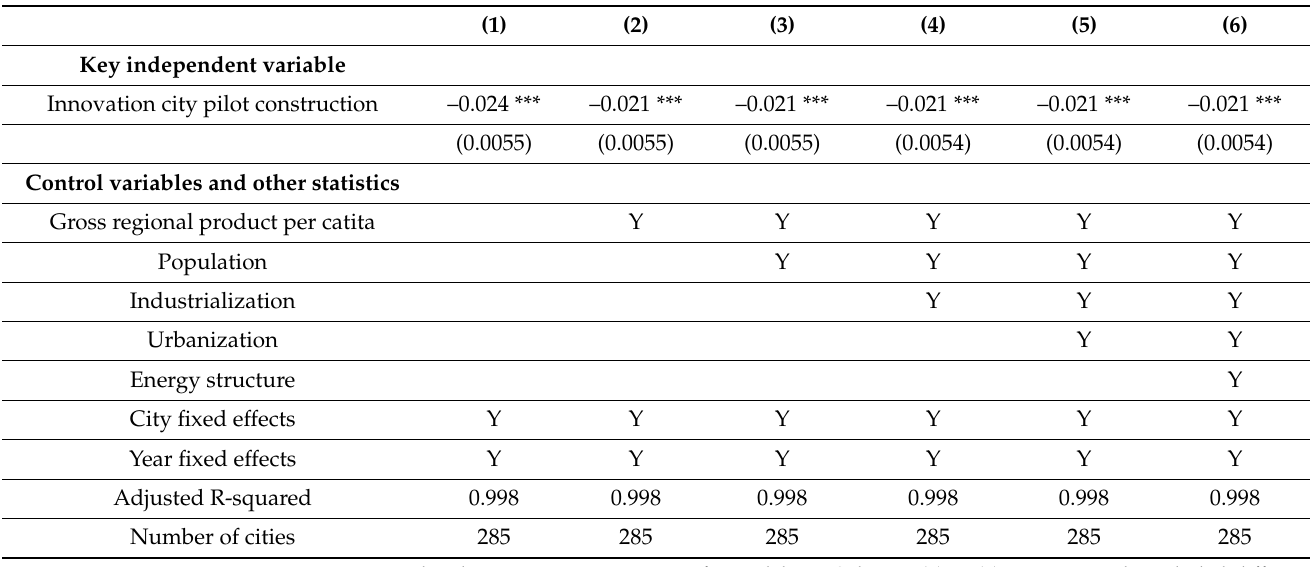
Table 1. Estimates in the impact on carbon emissions from difference-in-differences